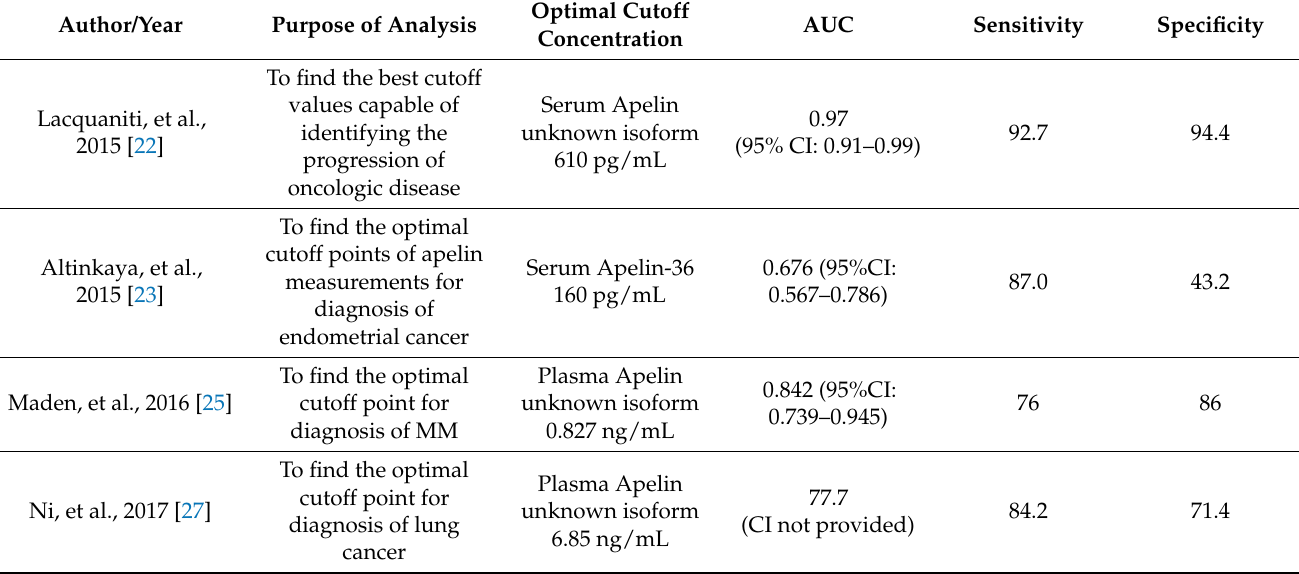
Table 5. Summary of results of ROC